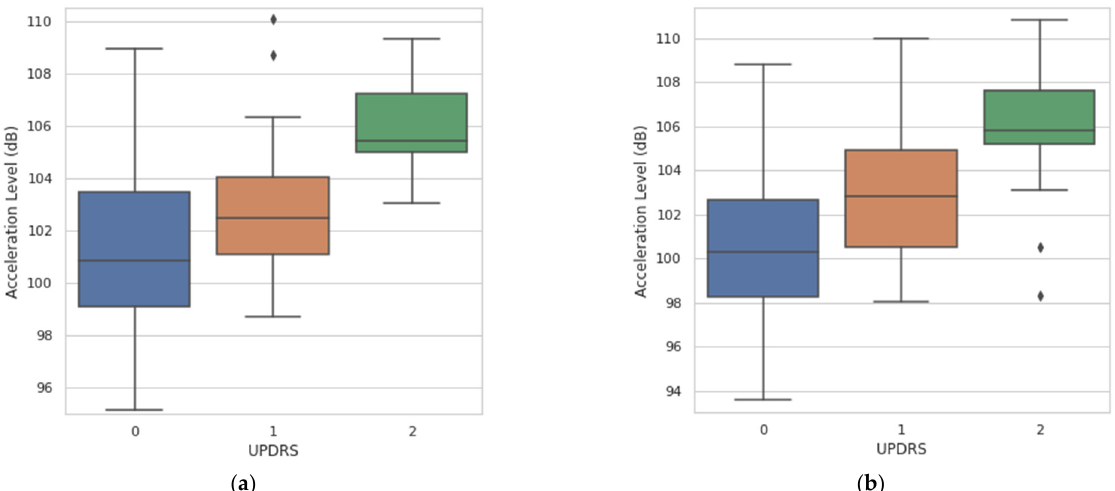
Figure 11. Agreement between the measurements of acceleration level derived from the resting tremor assessment and the UPDRS clinical score. ( a ) Agreement obtained with the multitask CNN with FFT. ( b ) Agreement obtained with the multitask CNN with raw signals.